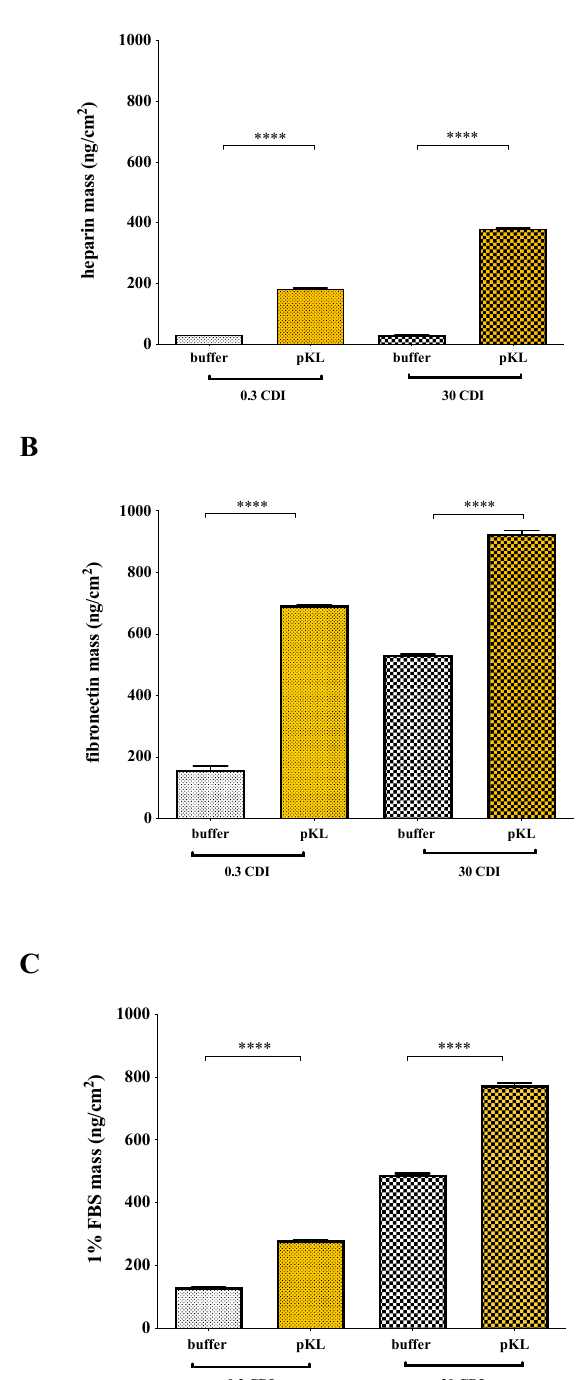
Figure 2. Protein adsorption at the surfaces as quantified by QCM-D . QCM-D results for protein adsorption on pKL-SAMs or in buffer-SAMs. ( A ) heparin [0.1 mg/mL]; ( B ) fibronectin [40 µ g/mL]; ( C ) 1% ( v / v ) FBS solution. Data are expressed as average ± STDEV of three replicates per condition. Statistically significant difference (**** p < 0.0001) .